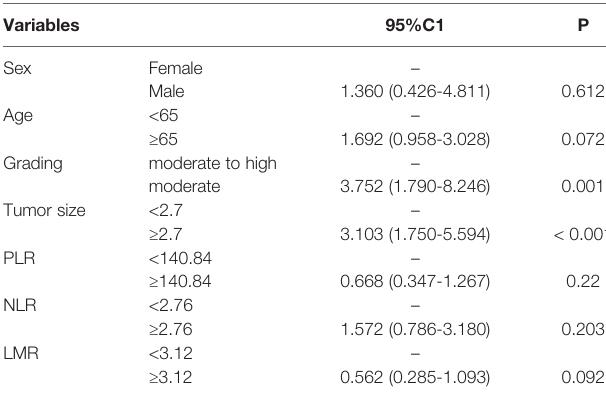
TABLE 3 | Multivatiate logistic regression analysis for predicting lymph node